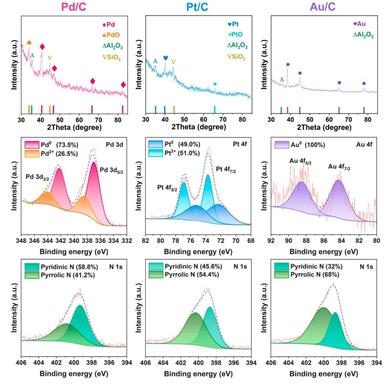
XRD and XPS patterns of Pd/C, Pt/C, and Au/C.